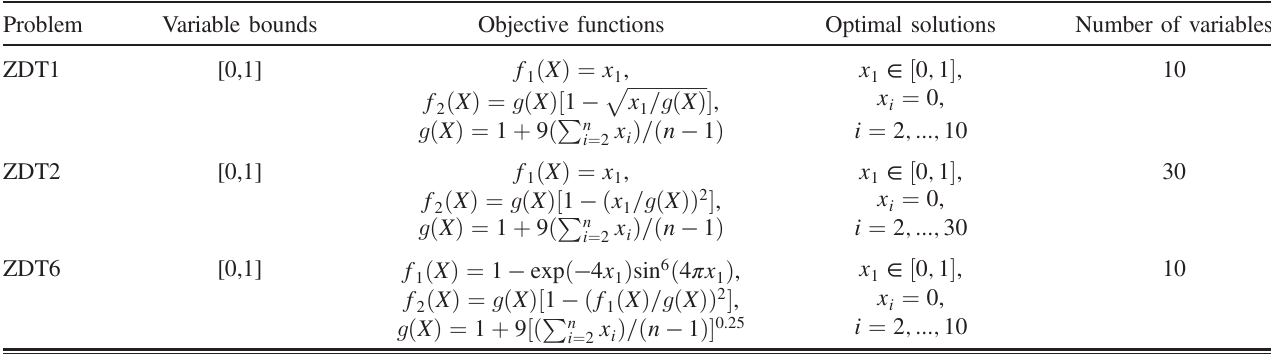
TABLE III. Details of three test problems. All the objective functions are to be minimized.